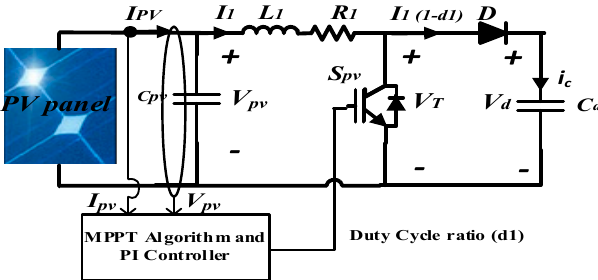
Figure 3. Schematic configuration of the PV system interface with the DC side of the hybrid microgrid.